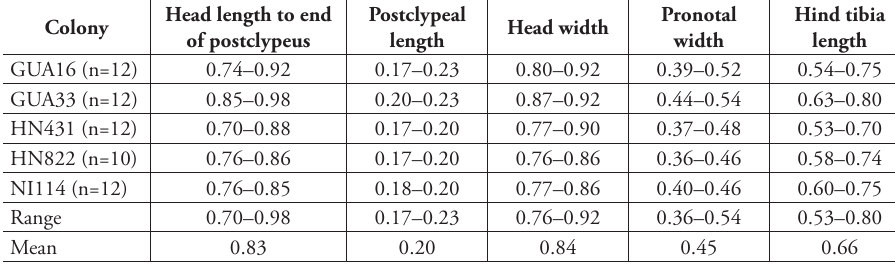
Table 4. Measurements (mm) of Parvitermes mesoamericanus sp. n. workers.